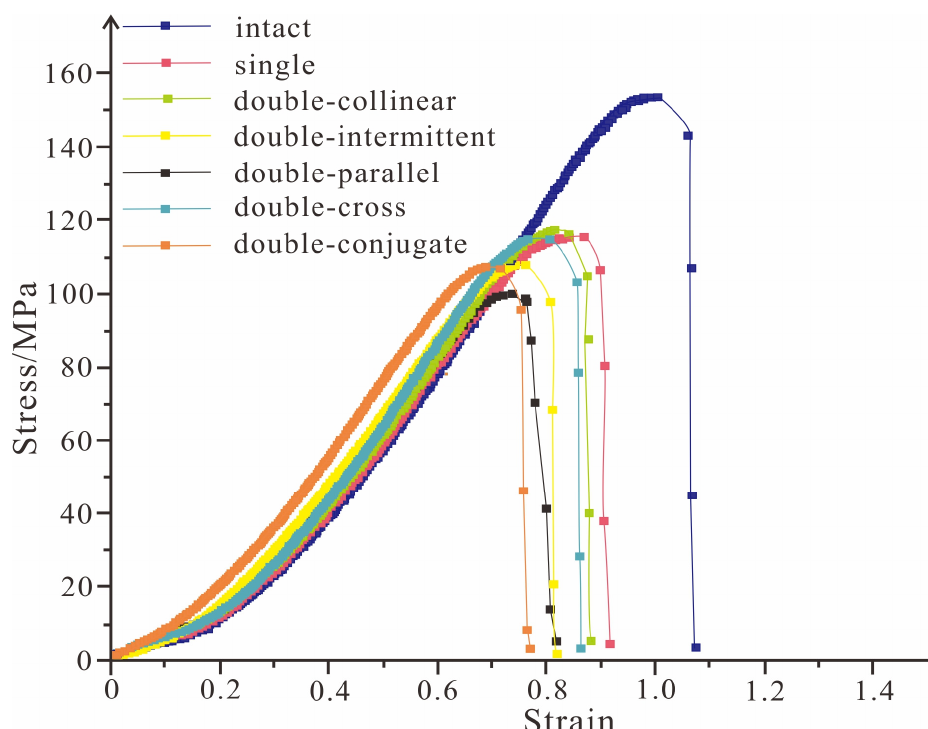
Figure 7. Strength of rock samples.